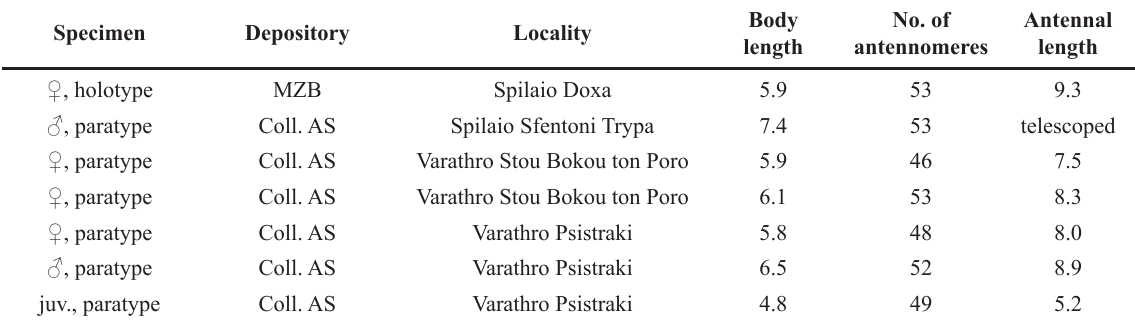
Table 6. Plusiocampa ( Plusiocampa ) hoffmanni Sendra & Paragamian sp. nov. Length of the body and antennae (measurements in mm), in addition to the number of